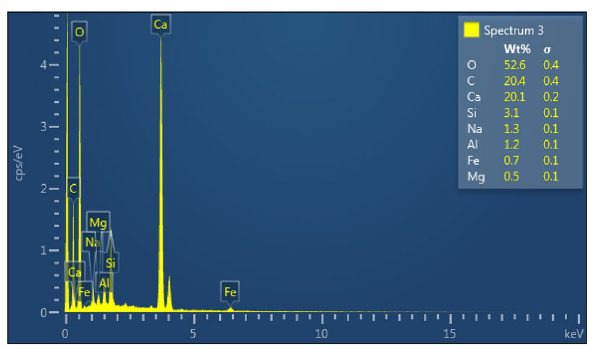
Fig. 3 Modest element identification in the